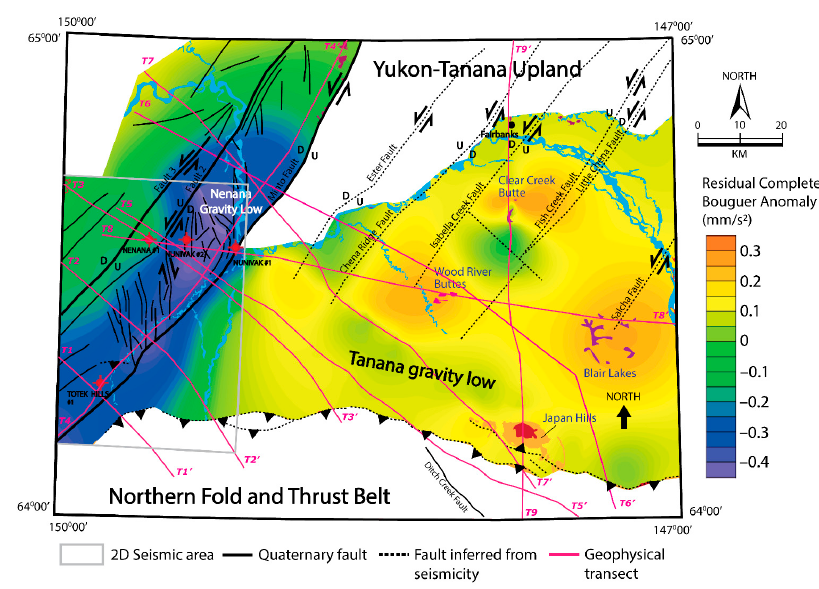
Figure 8. The final residual gravity anomaly map of the study area. The residual gravity field was calculated by isolating the long-wavelength regional gravity field using polynomial approximation methods.